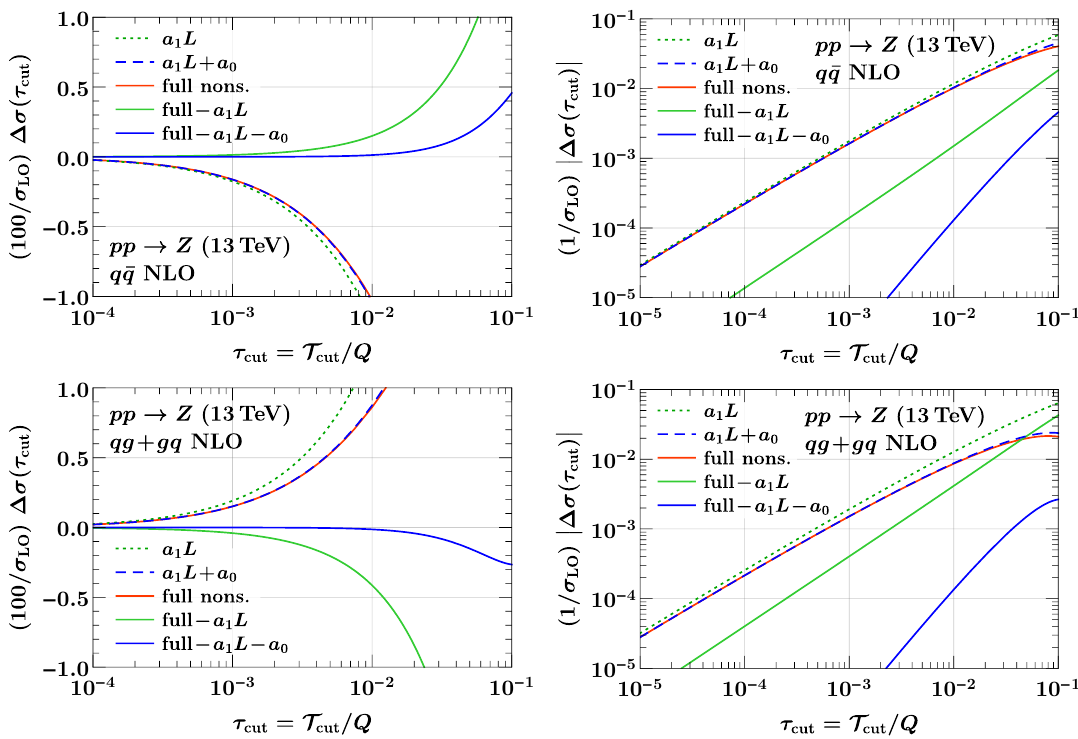
Figure 3 . The power corrections for the cumulative (cid:1) (cid:27) ( (cid:28) cut ) at O ( (cid:11) s ) for Z production in the q (cid:22) q channel (top row) and qg + gq channel (bottom row). In both cases, after the inclusion of the NLL power corrections, (cid:1) (cid:27) ( (cid:28) cut ) is reduced by a factor of 100 or more for (cid:28) cut < 10 (cid:0) 2